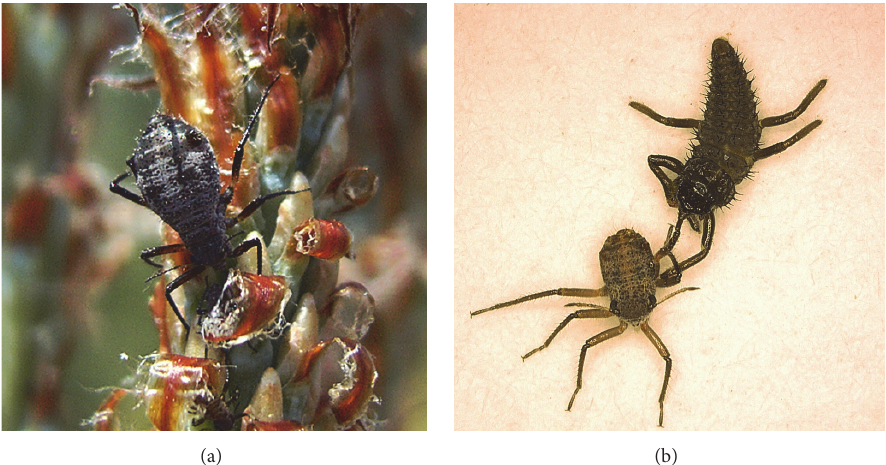
Figure 3: (a) A giant pine aphid, Cinara pini , on Japanese red pine, Pinus densiflora . (b) Harmonia yedoensis hatchling capturing a C. pini individual, observed in a laboratory experiment. Because C. pini has long legs and is highly mobile, H. yedoensis larvae are often unsuccessful in their attempts to capture this